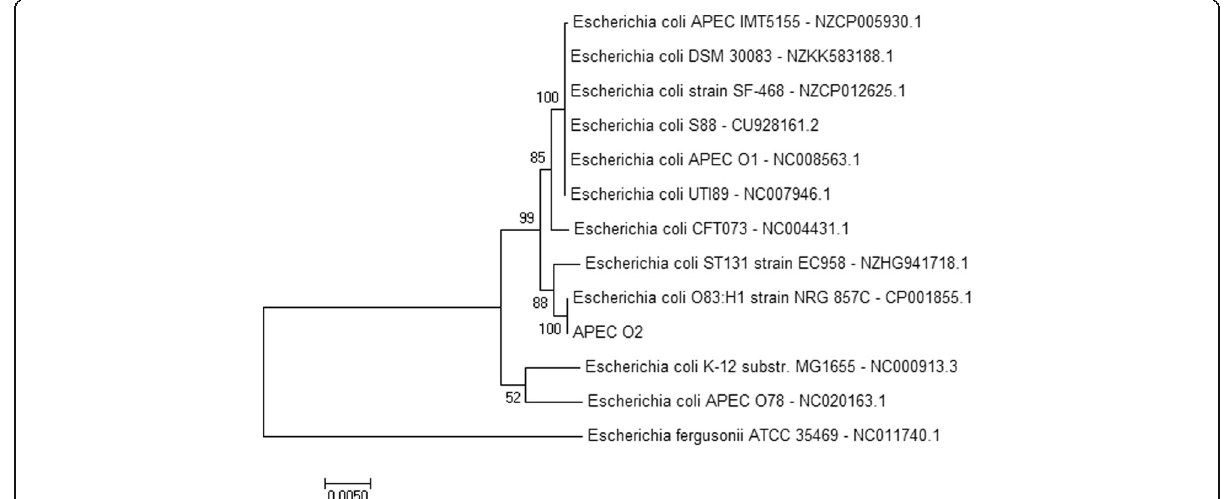
Fig. 2 Maximum likehood tree of APEC_O2 relative to other closely related strains. The phylogenetic tree was constructed from the concatenated seven housekeeping genes ( adk, fumC, gyrB, icd, mdh, purA, and recA ) in MEGA software version 7. Escherichia fergusonii (ATCC35469) was used as an out-group. Bootstrap values of 500 replicates are indicated at the nodes. The scale bar indicates nucleotide diversity between the